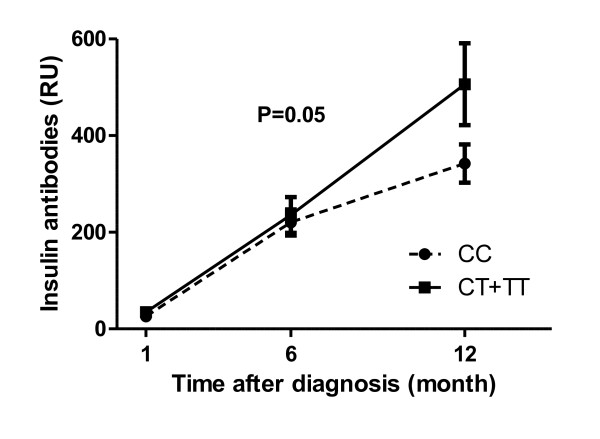
Insulin antibodies over time according to PTPN22 genotypes. Distribution of insulin antibodies (IA) by PTPN22 genotype ((CT+TT) (n = 71) carriers of the variant versus wildtype (CC) (n = 186)) 12 months after disease onset. Mean values (pmol/l) ± SEM.